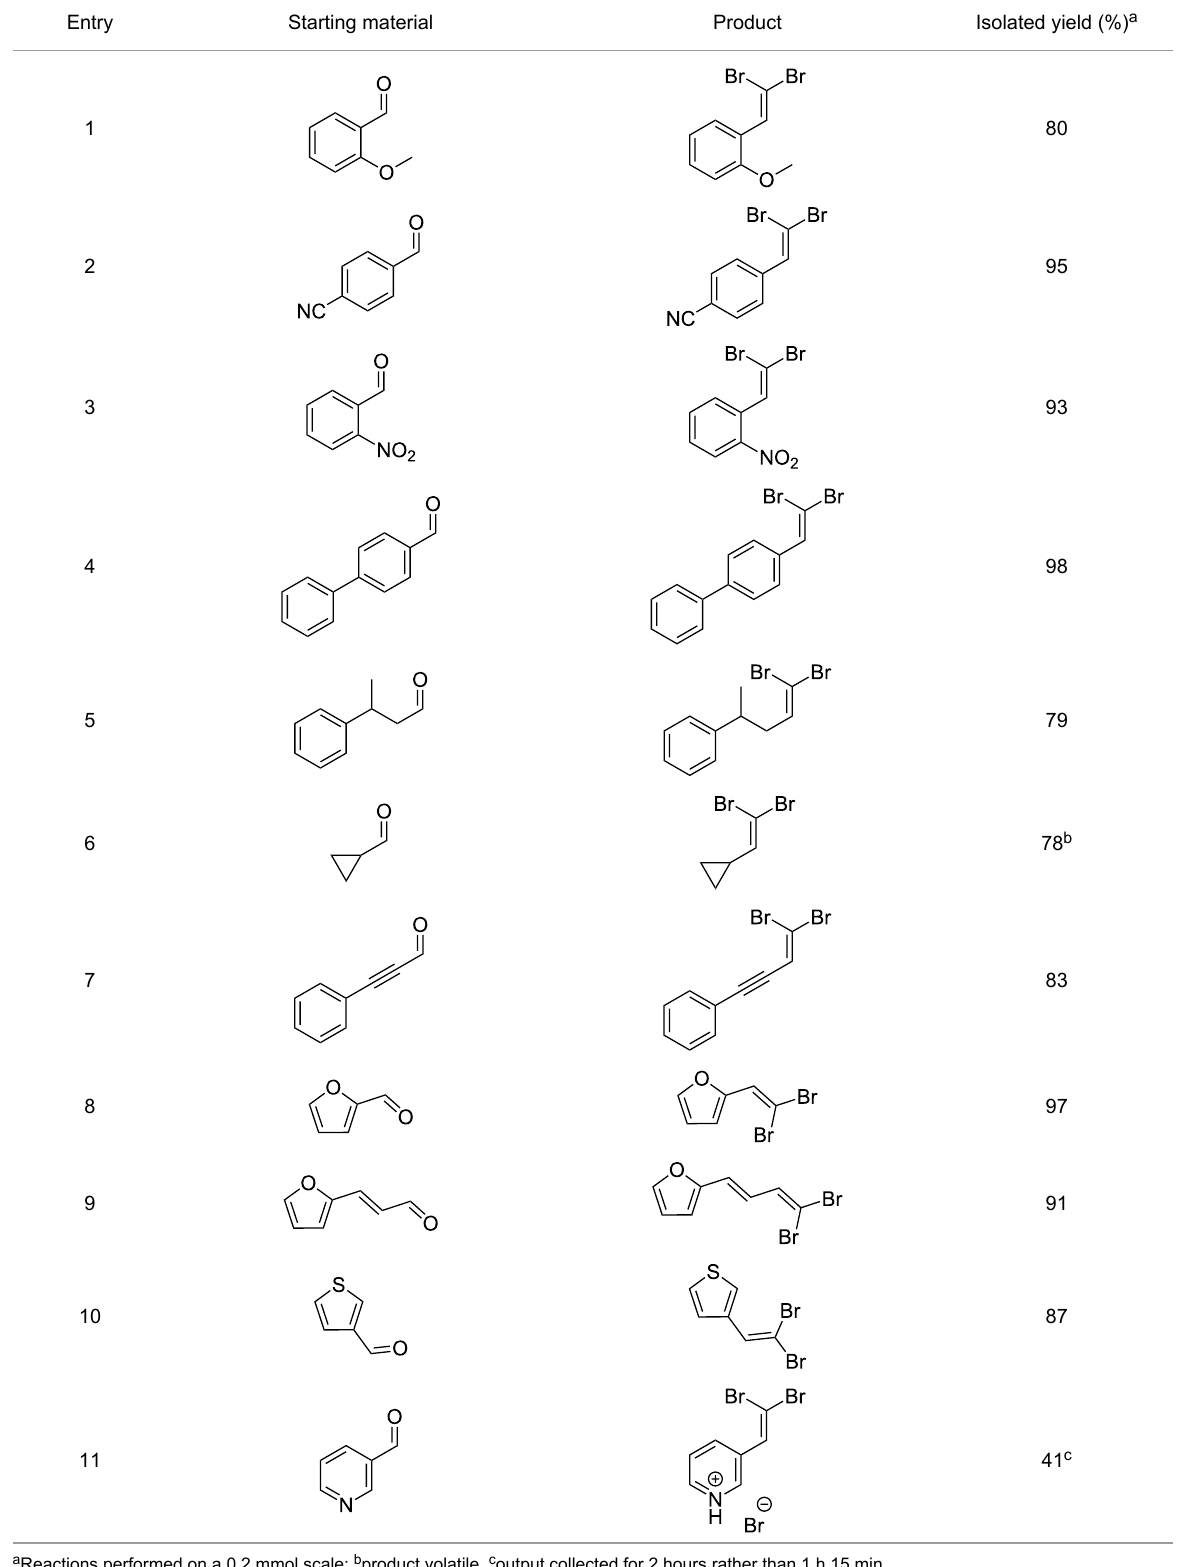
Table 1: Gem -dibromides prepared from the corresponding aldehydes using the triphenylphosphine monolith in flow.